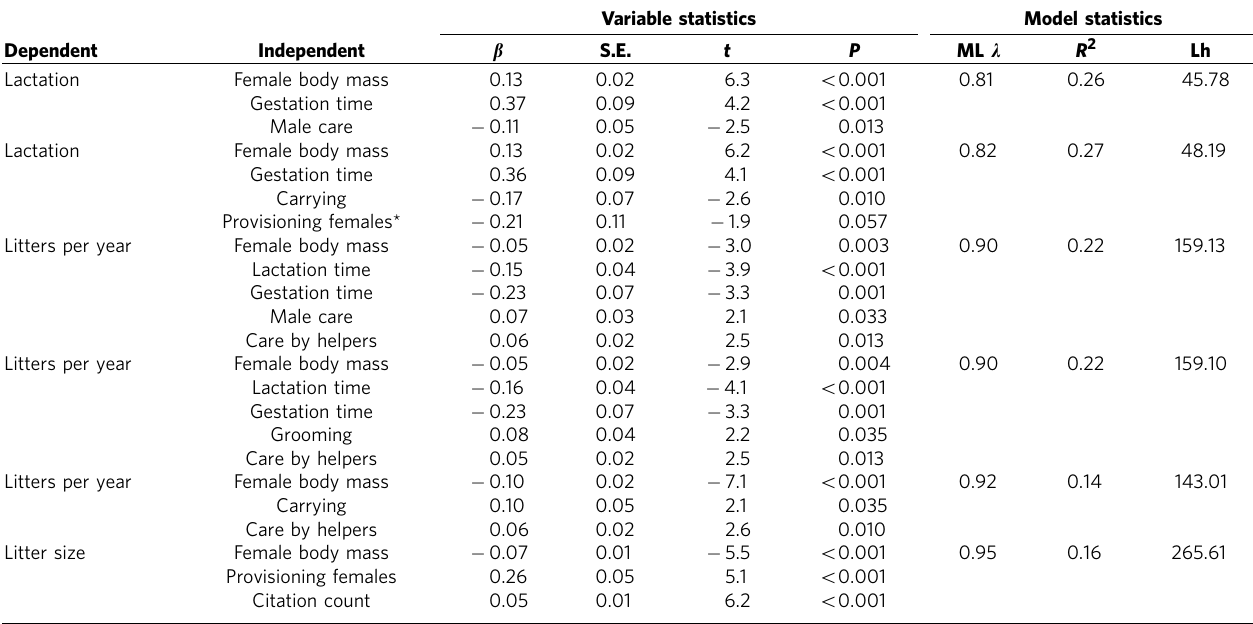
Table 1 | Reduced PGLS multi-predictor models for lactation time, litters per year and litter size with male care (any behaviour) and significant individual behaviours.